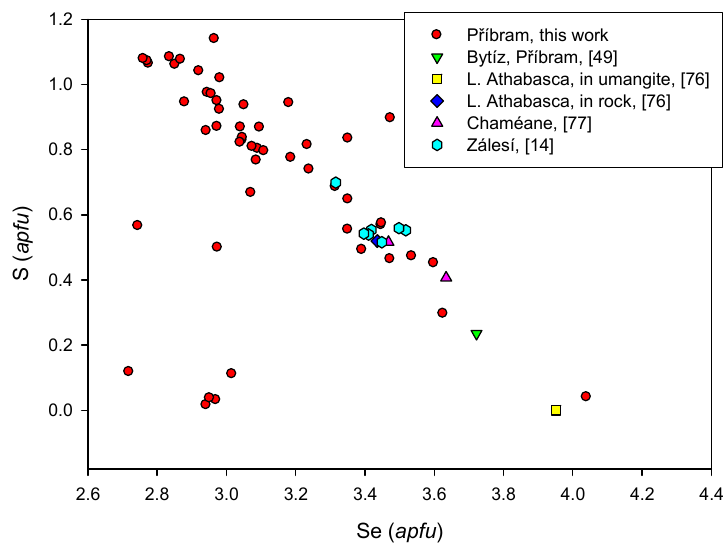
Figure 8. Se vs. S ( apfu ) graph of athabascaite from various localities.